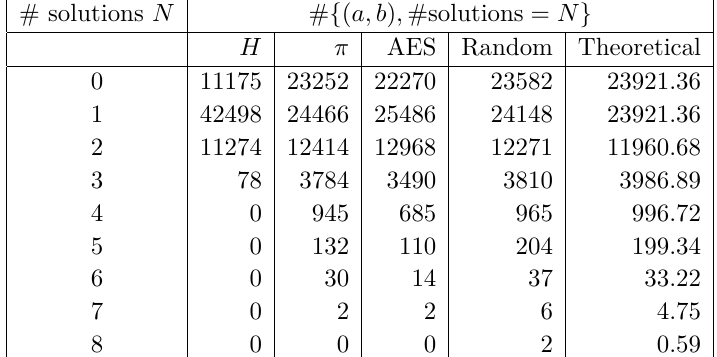
Table 3: The distribution of the number of solutions of 𝑠 ( 𝑥 (cid:1) 𝑎 ) ⊕ 𝑠 ( 𝑥 ) = 𝑏 depending on 𝑎 and 𝑏 for different S-Boxes and for a Poisson